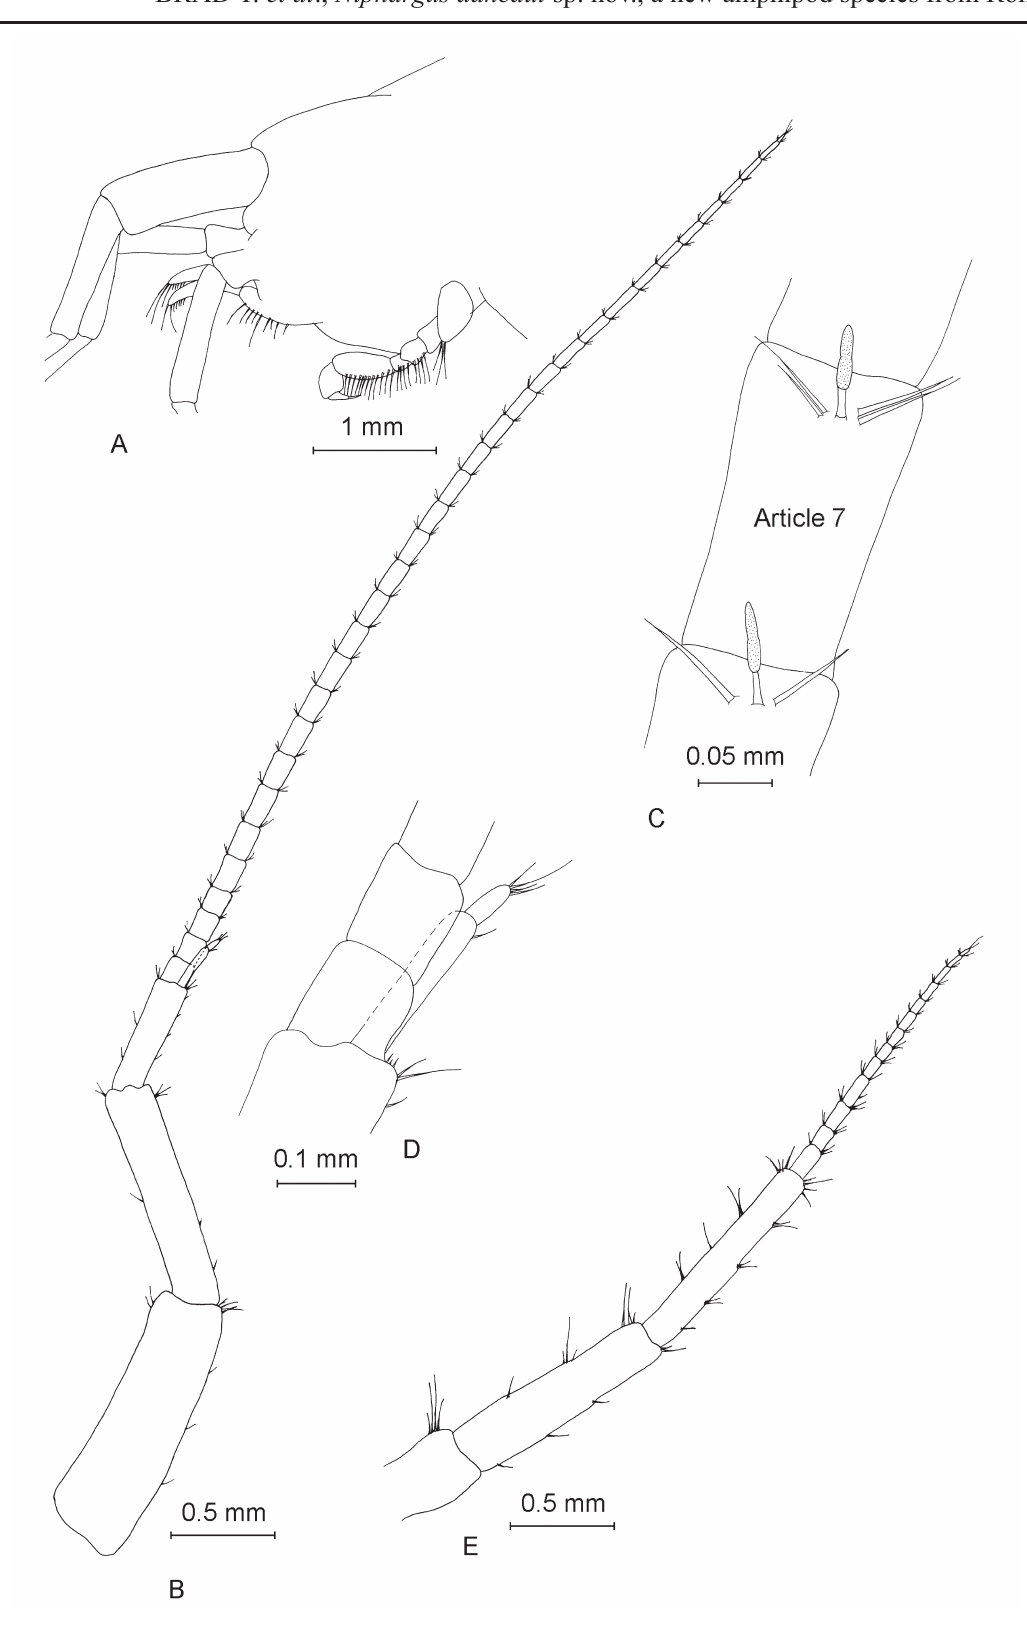
Fig. 3. ♂. A . Head. B . Antenna I. C . Aesthetascs of antenna I. D . Accessory flagellum of antenna I. E . Antenna